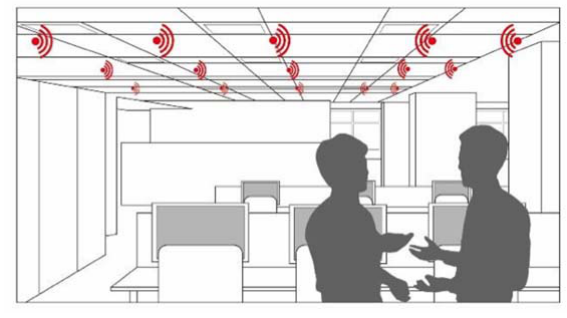
Figure 1. An image of acquisition of positional information using sensors Source: Press release material from MITSUI Designtec Co.,